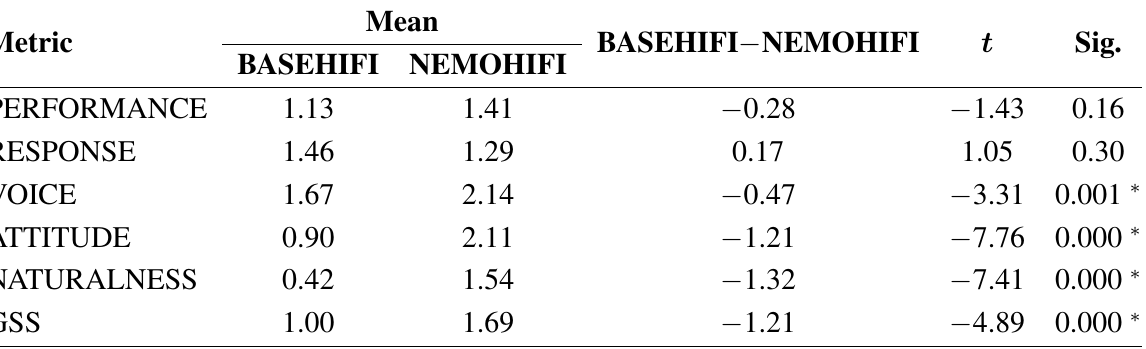
t -test results comparing the mean subjective ratings between BASEHIFI and